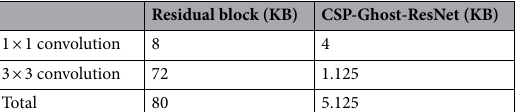
Residual block (KB) CSP-Ghost-ResNet (KB)